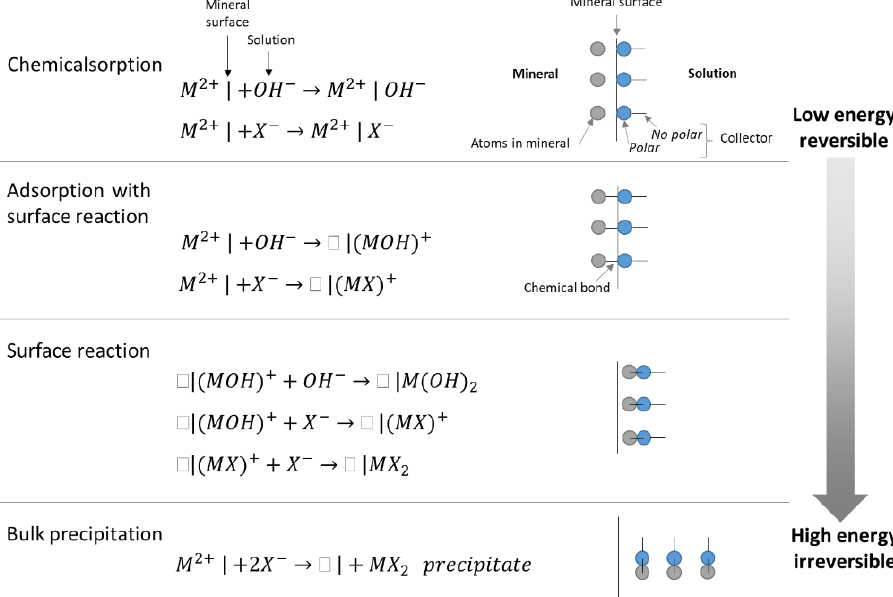
Figure 20. Schematic representation of the pyrite surfaces without treatment ( left ), with lime treat- ment ( center ), and with NaOH treatment ( right ) (adapted from John et al. [80]).